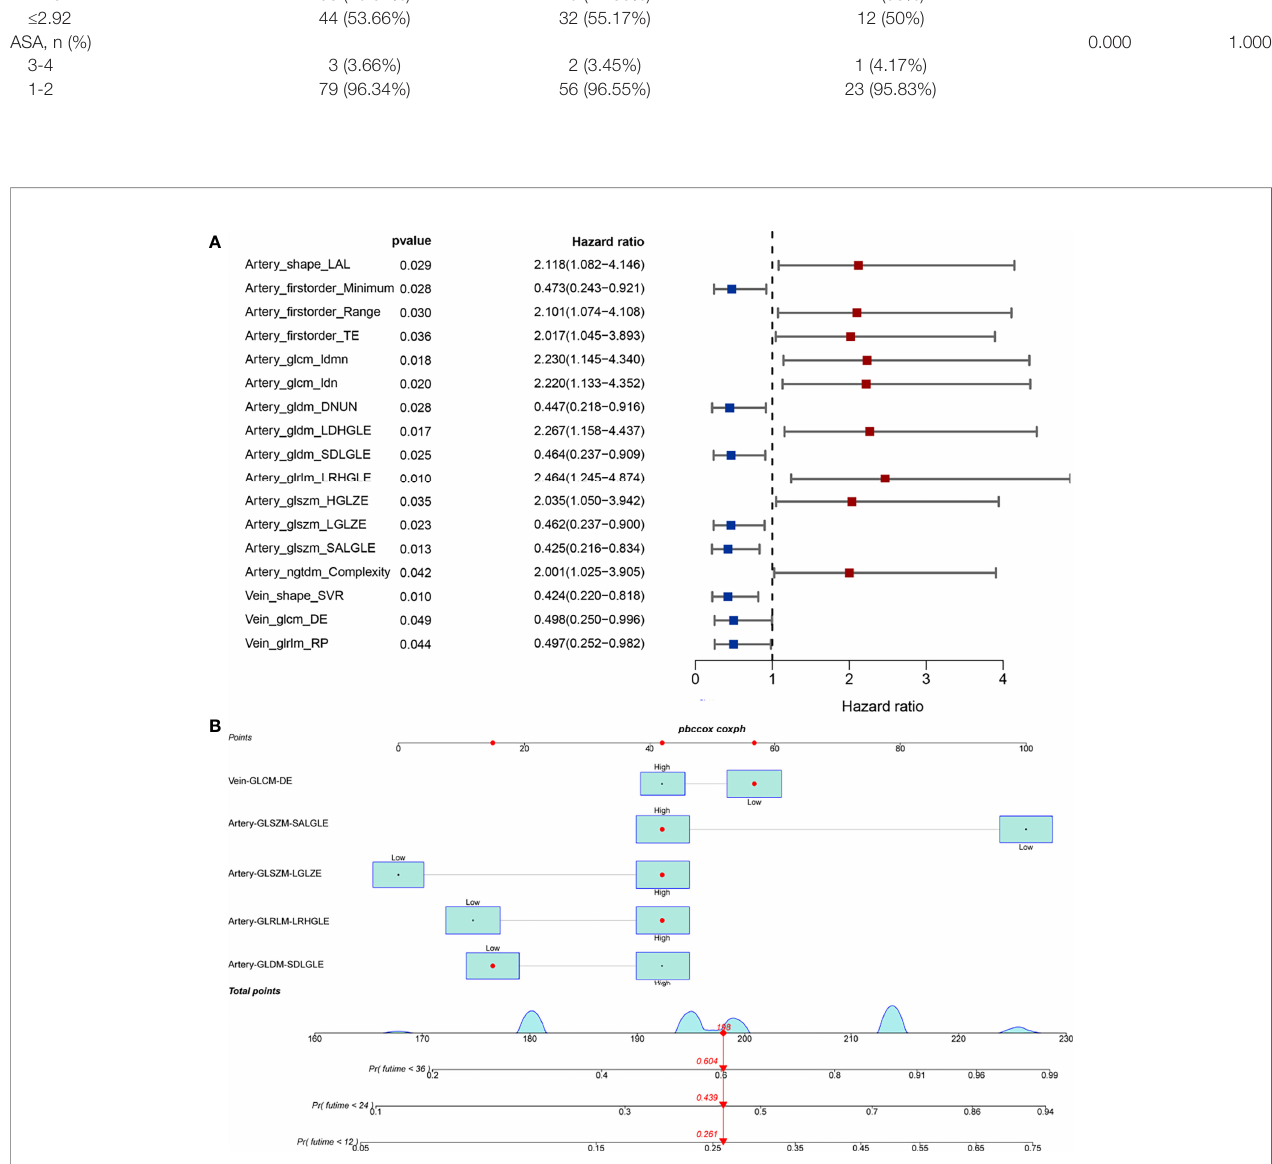
FIGURE 2 | Development of radiomics model in mass forming ICC patients. (A) The univariable analysis identi fi ed the radiomics prognostic factors of OS; (B) Established radiomics nomogram of